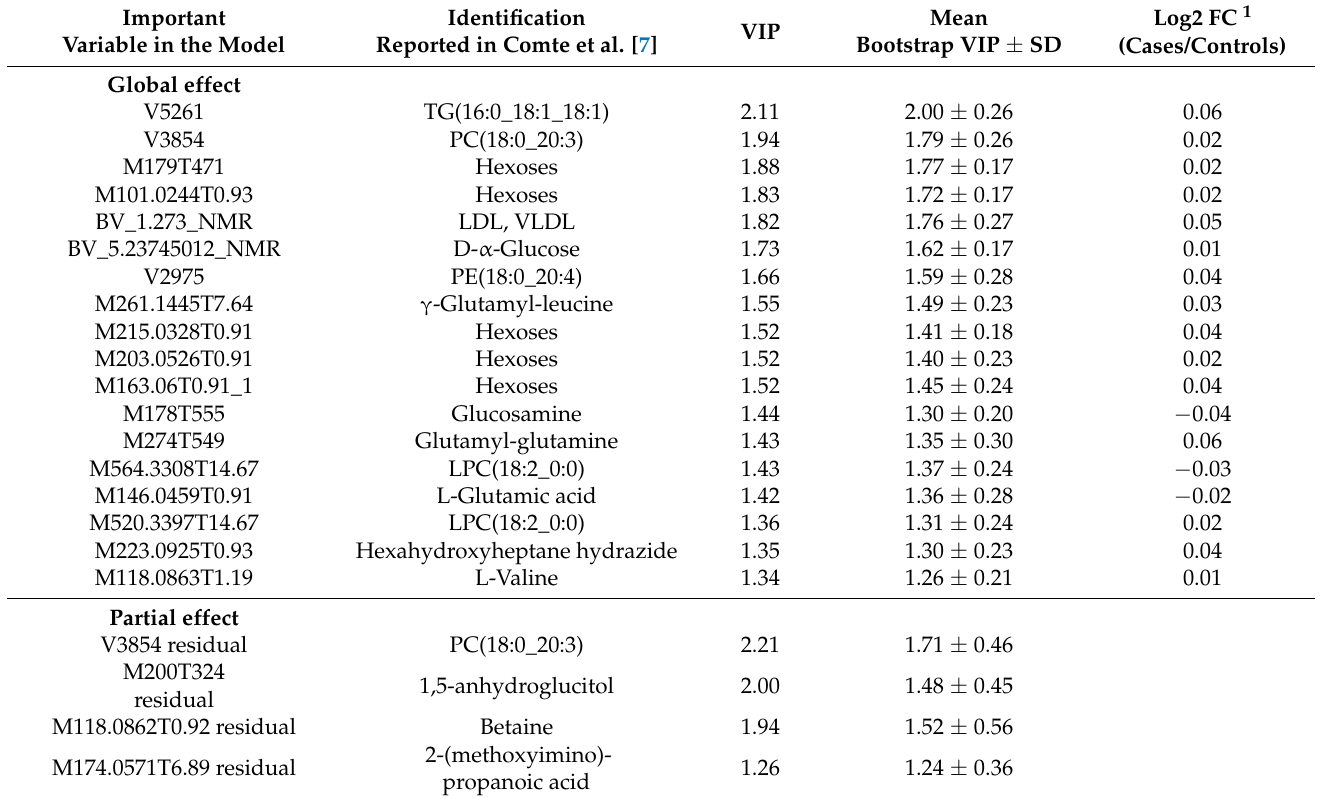
Table 3. Identifications, VIP and Log2 FC of the most important metabolomics variables in the effects of Metabo on y in path